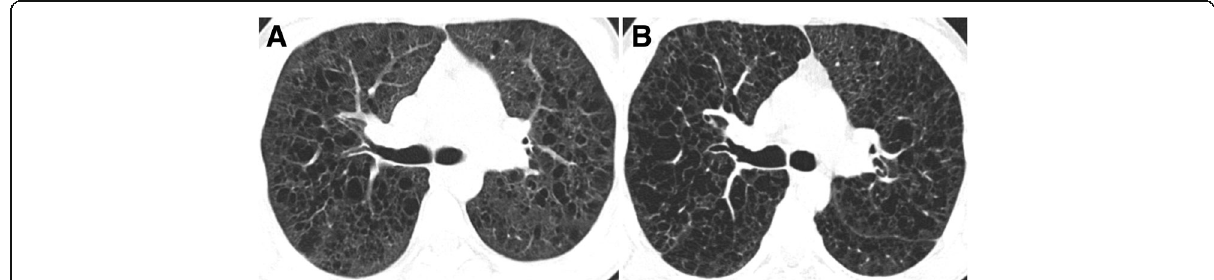
Fig. 13 PLCH. Progression of the imaging findings over time (10-year interval), despite smoking cessation, in a 30-year-old man. a Axial CT image showing diffuse bizarre cysts with walls of varying thickness. b Axial CT image at 10-year interval showing progression of the number and size of